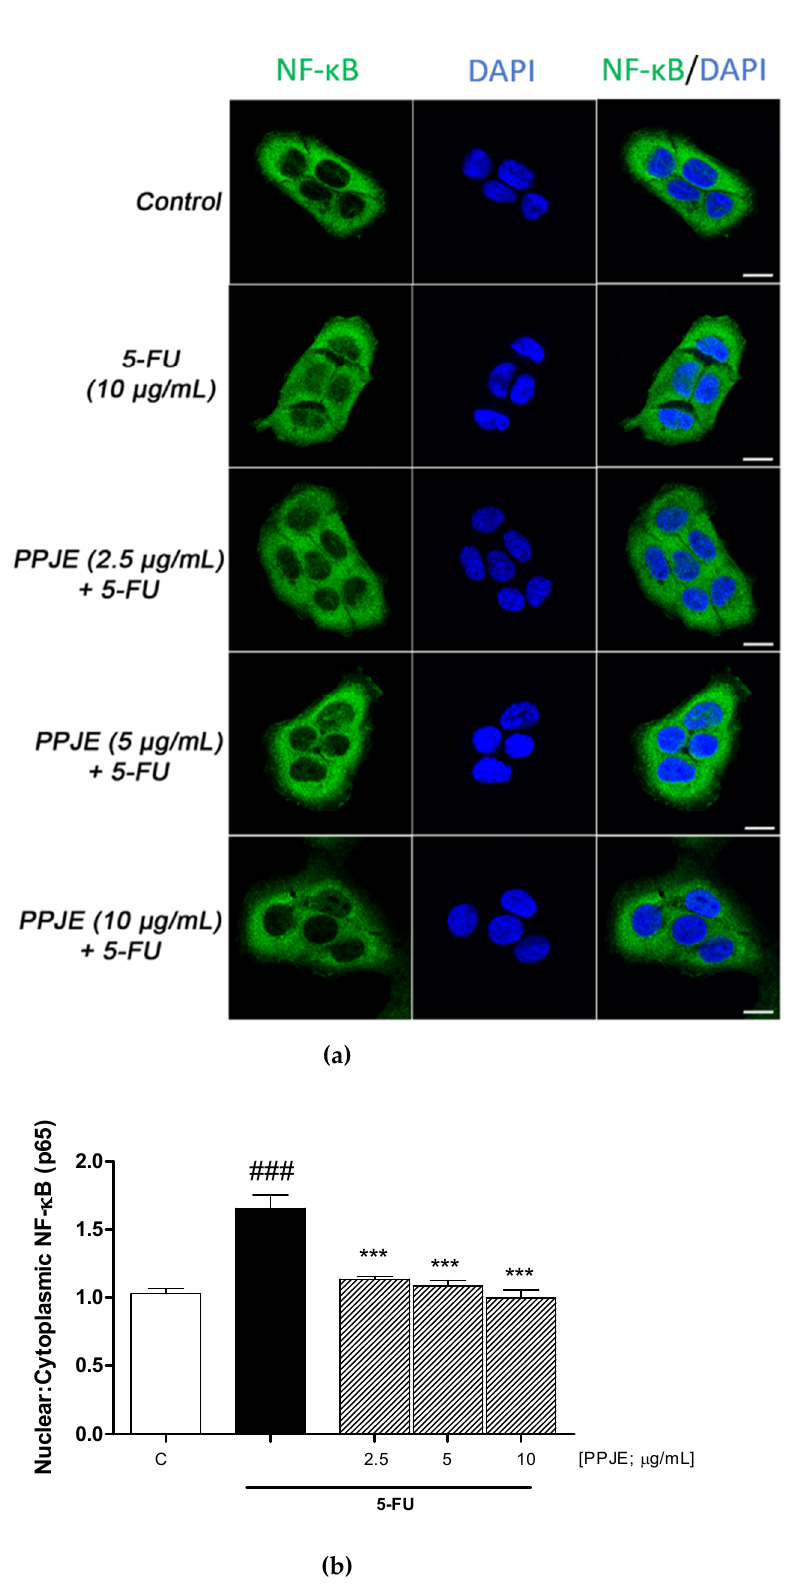
Figure 4. Immunofluorescence staining of NF- κ B ( a ) and quantification of nuclear/cytoplasmic ratios of NF- κ B staining ( b ) in HaCaT cells treated for 4 h with 5-FU (10 µ g/mL) alone or in combination with increasing concentration of PPJE (2.5–10 µ g/mL). ( b ) Histograms represent the mean ± s.e.m. of nuclear/cytoplasmic ratios of NF- κ B staining calculated as described in methods section. C denotes control group. ### denotes p < 0.01 vs. C; *** denote p < 0.001 vs. 5-FU.